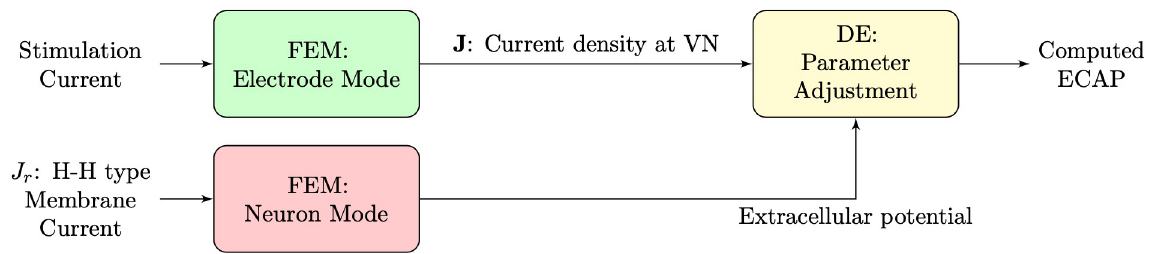
Fig 1. The three main stages of the computational